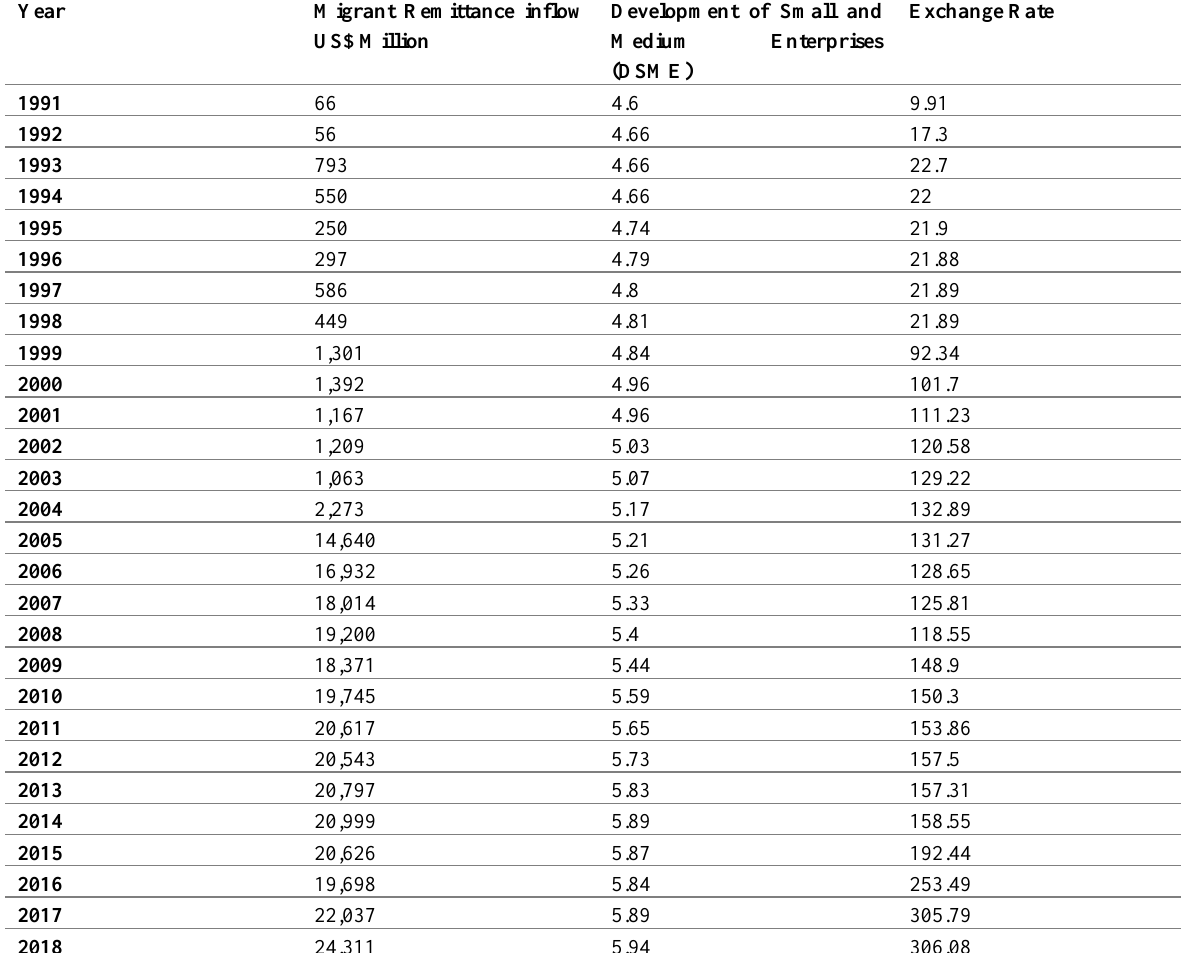
Table 6: Diaspora remittances, Development of SMEs and Exchange rate